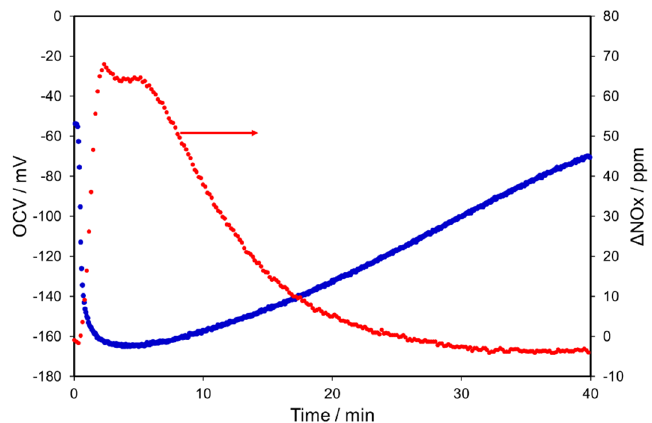
Figure 3. Variations of open ‐ circuit voltage (OCV) and Δ NO x as a function of time at 500 °C. Reactive mixture: NO/NO 2 : 680 ppm/10 ppm in He. mixture: NO/NO 2 : 680 ppm/10 ppm in